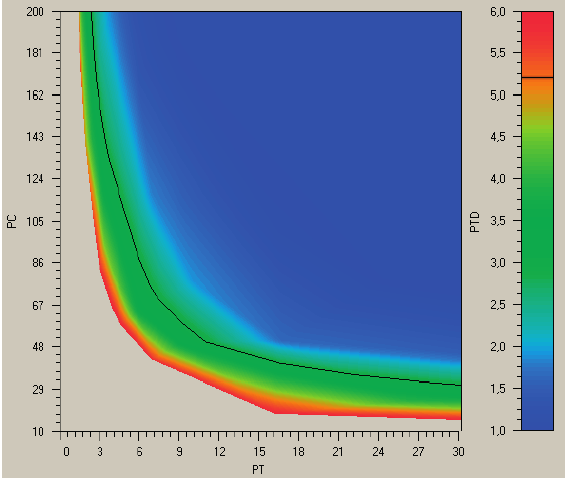
Figure 7. Marginal feasible proliferation scenario set (interactive decision map representation, PT (days): proliferation time, PC (c.u.): proliferation cost, PTD (kgSWU/yr): proliferation technical